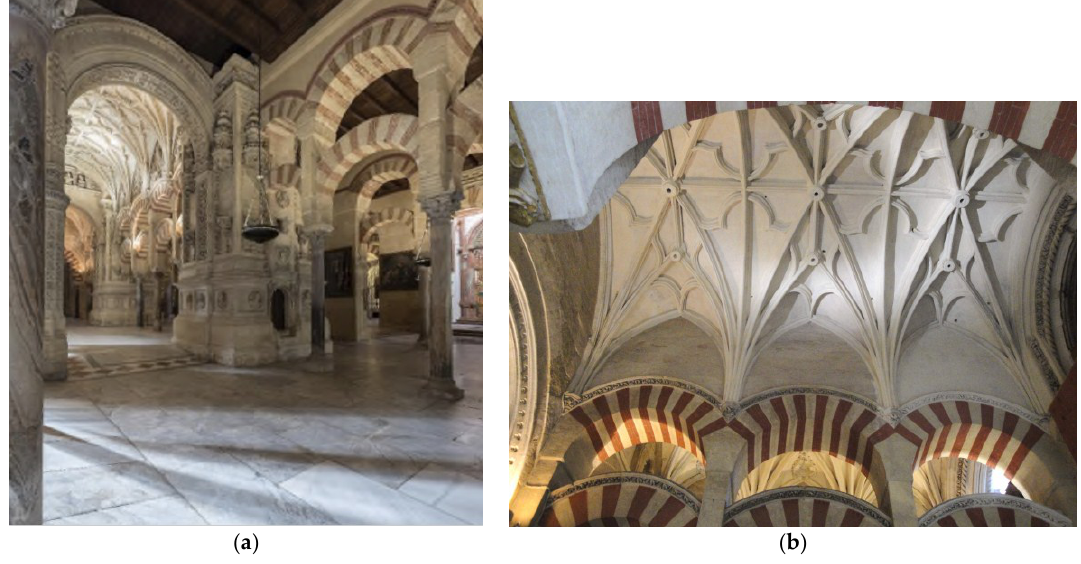
Figure 1. Hernan Ruiz I. Mosque-Cathedral of Cordoba: ( a ) Transition from Abd al Rahman I’s naves to the Christian nartex. © Cabildo Catedral de Córdoba; ( b ) stellar vaults in the perimeter of the Latin cross. Photo took by author.